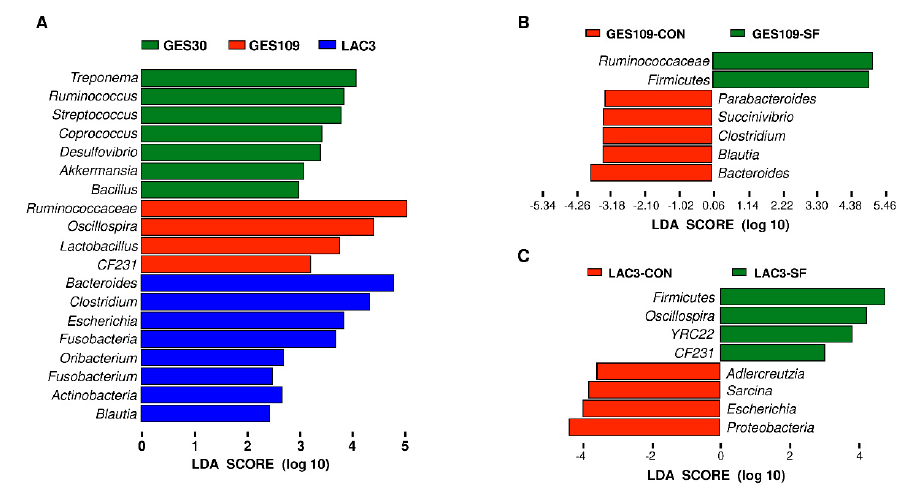
Figure 3. The linear discriminant analysis coupled with effect size (LEfSe) analysis of gut microbiota composition of CON and SF sows. (A–C) The key taxa among different breeding stages ( A ) and between different dietary treatments at day 109 of gestation ( B ) and day 3 of lactation ( C ). GES109, day 109 of gestation; LAC3, day 3 of lactation. LDA, linear discriminant analysis. CON, control diet; SF, 2.0% soluble fiber combination diet.